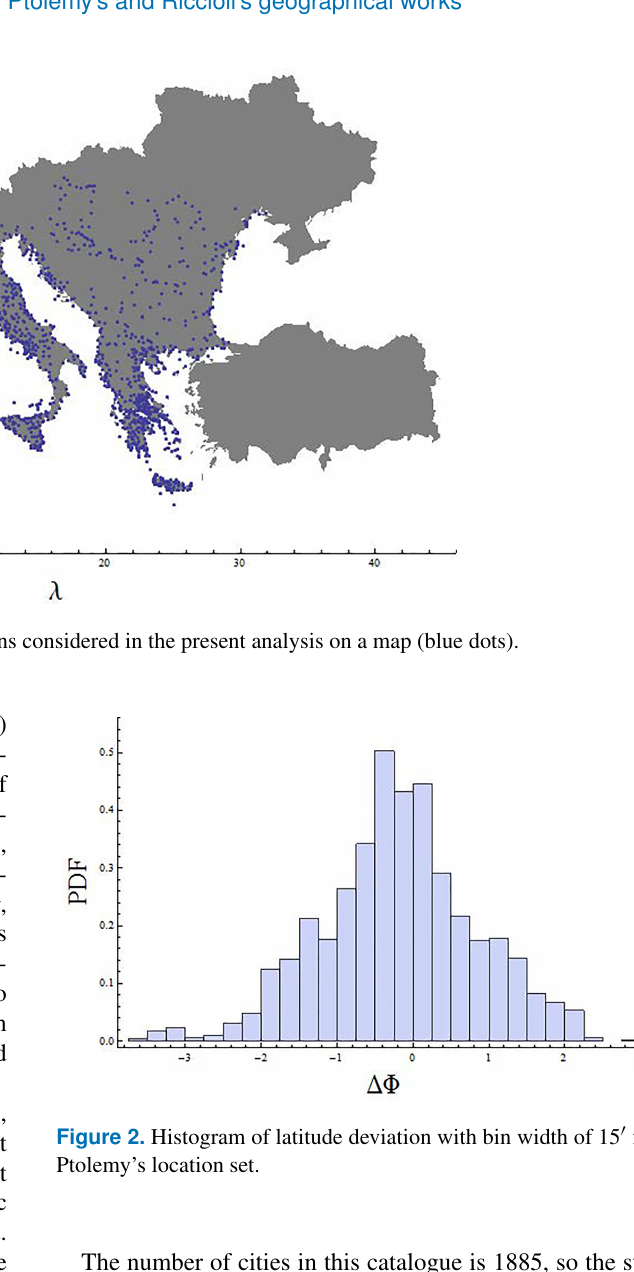
Figure 2. Histogram of latitude deviation with bin width of 15 (cid:48) for Ptolemy’s location